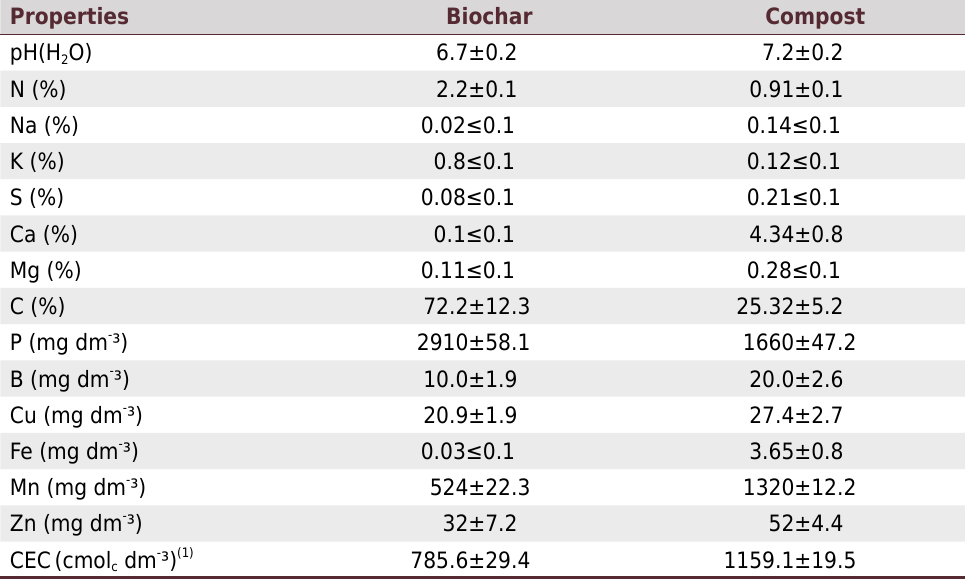
Table 1. Chemical characterization of organic compost and